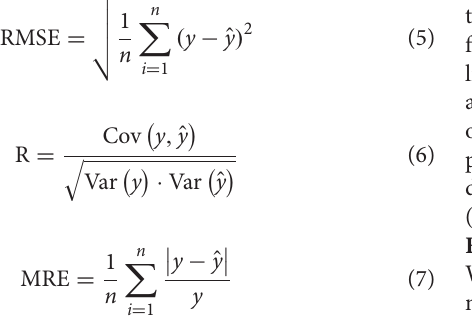
Figure 2 plots the RMSE calculations using the training